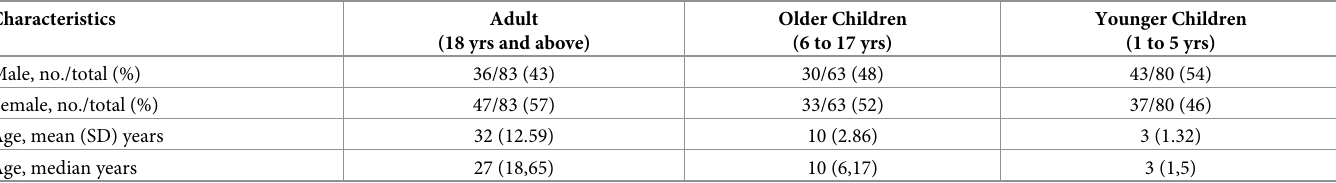
Table 1. Characteristics of study participants.